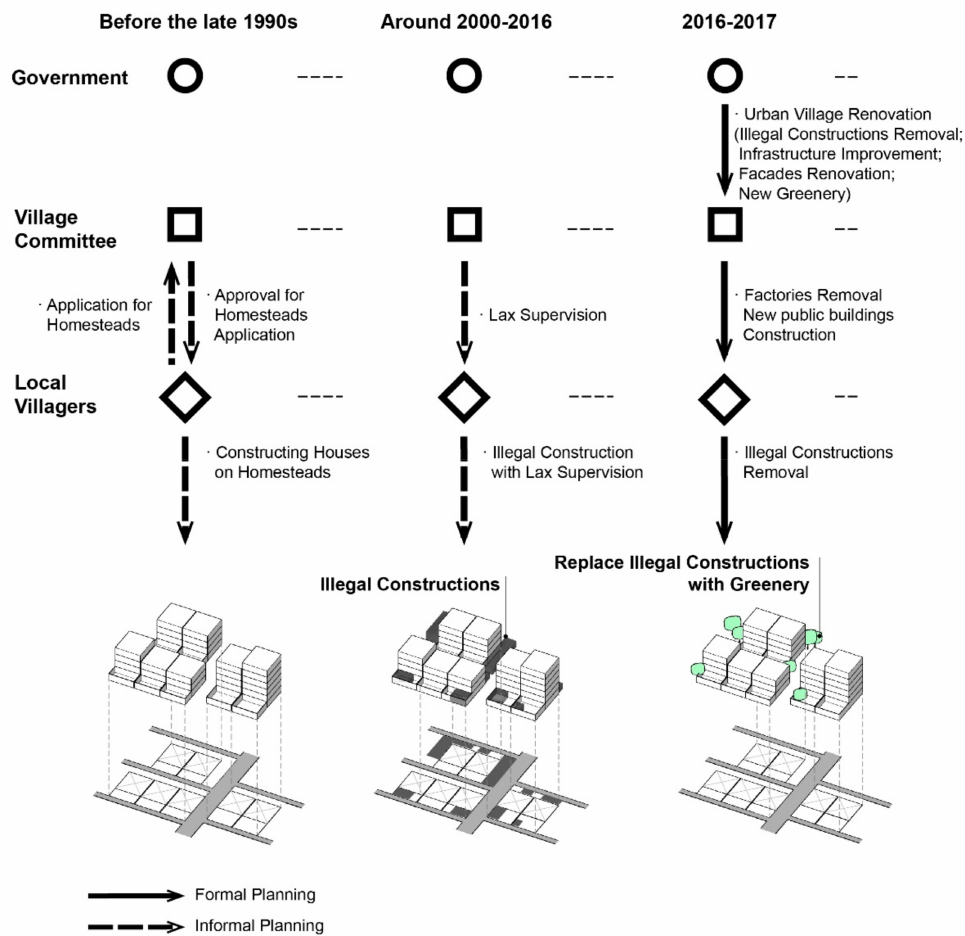
Figure 8. Planning and construction process of